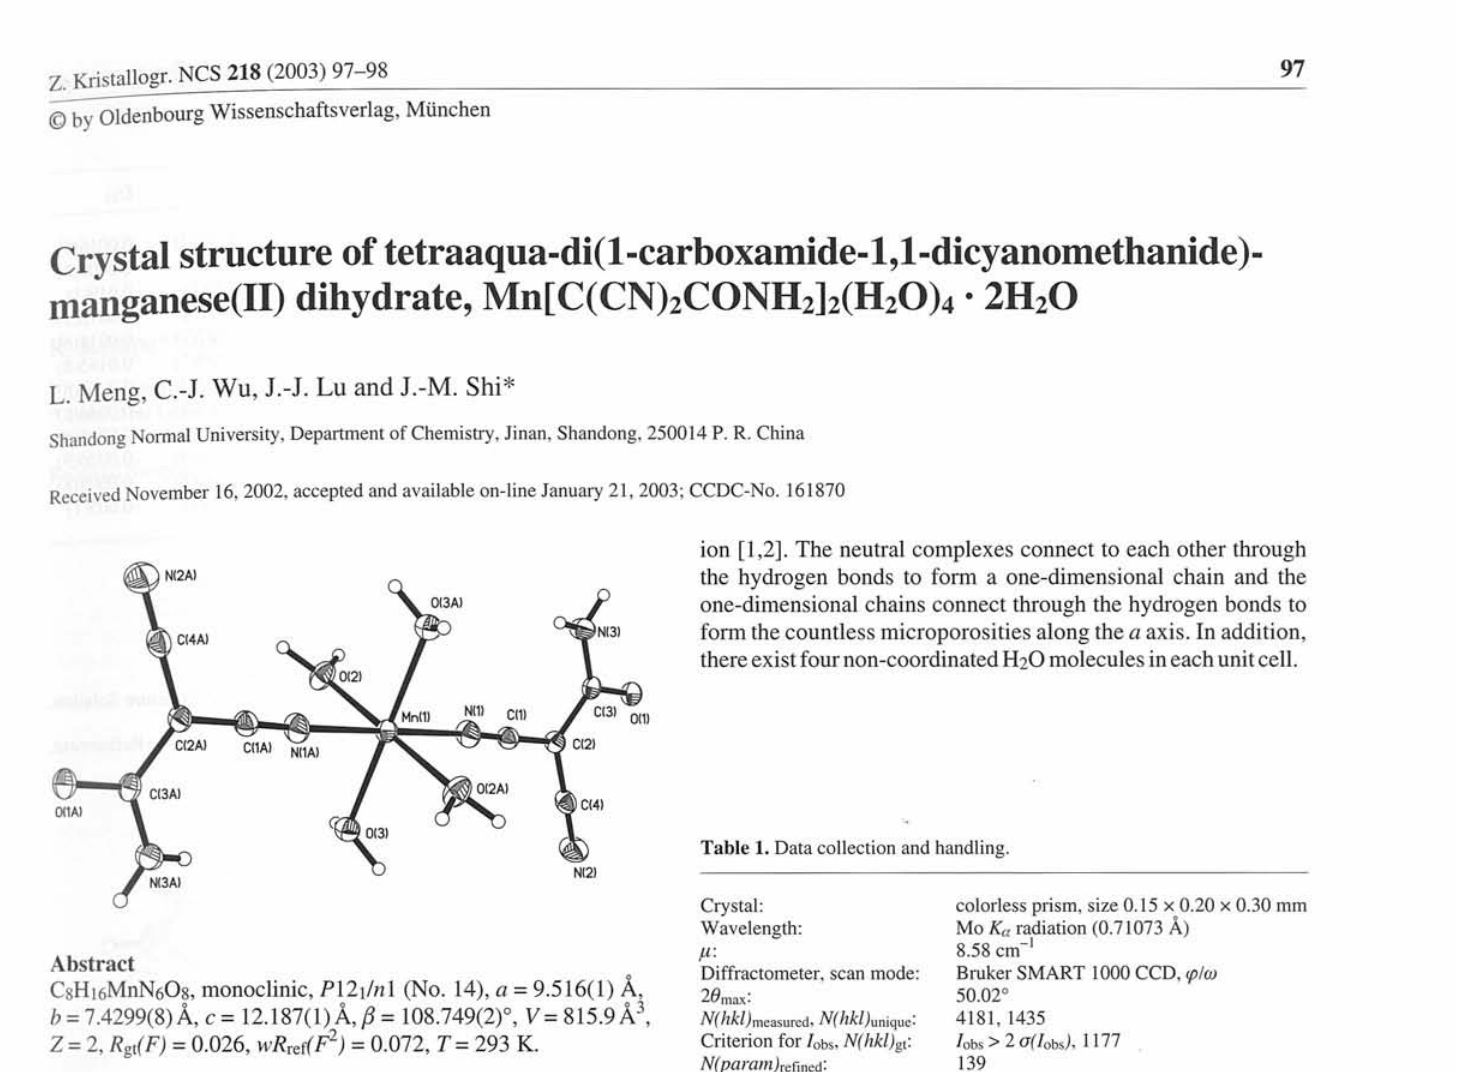
Table 1. Data collection and handling.